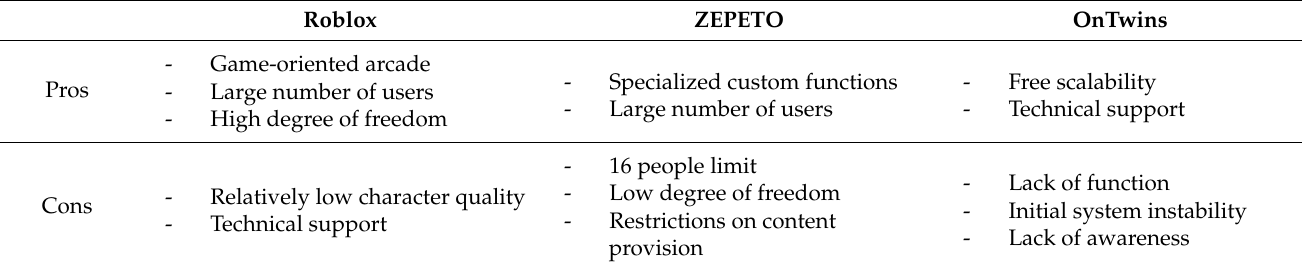
Table 6. Compare Seven